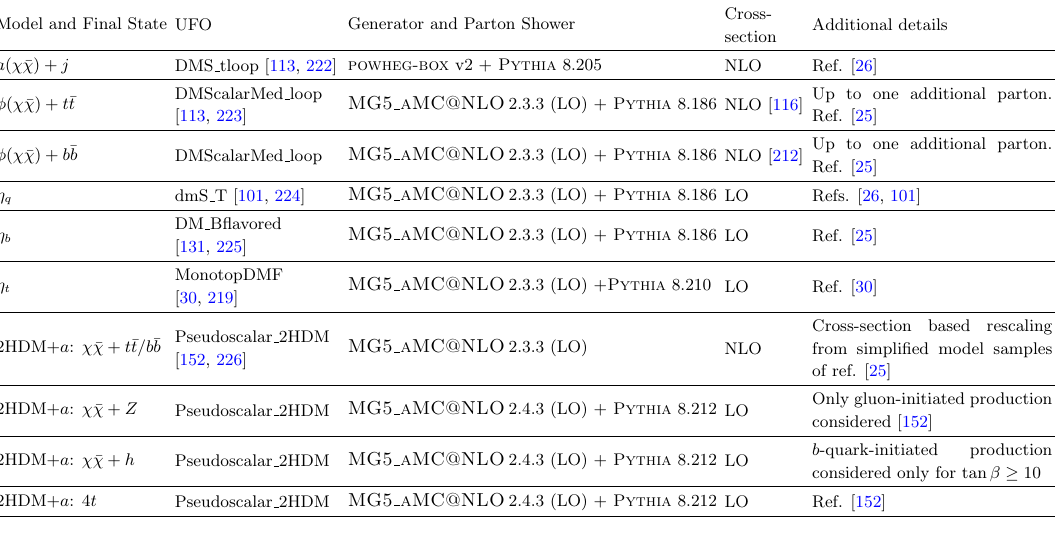
Table 5. Details of the generation setup and Universal FeynRules Output (UFO) model used for the spin-0 mediator models, for each signature considered in this paper.